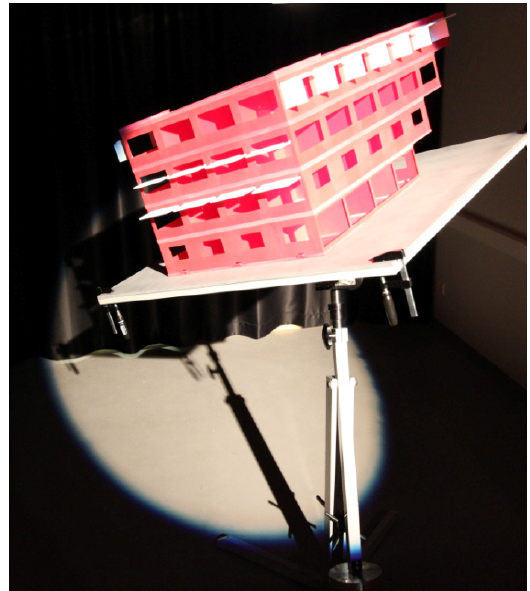
Fig. 4. Heliodon table at TUT daylighting laboratory